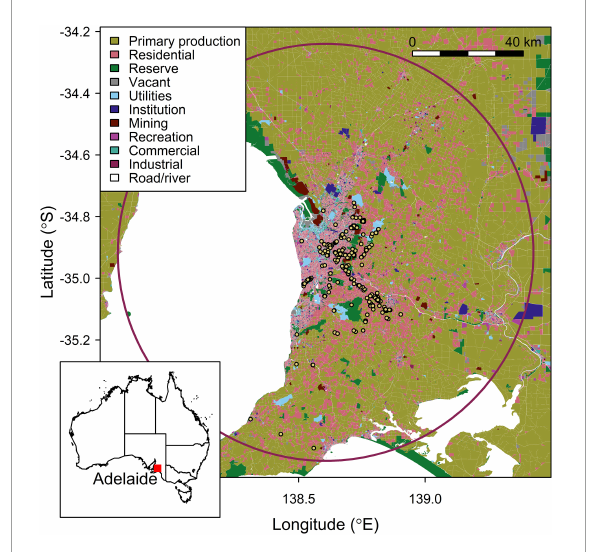
FIGURE1 Study area; the Adelaide region, depicted by a maroon circle (75 km radius) on the main map, and a red marker on the inlaid map of Australia. Land-use categories are indicated in the key. Pteropus poliocephalus feeding fixes are represented by yellow markers. All feeding fixes are 500 m–75 km from the center of the Adelaide Botanic Park roost; –34.916, 138.607. Data ( n = 489) were obtained from ( n = 9) GPS tracked P. poliocephalus and were collected between December